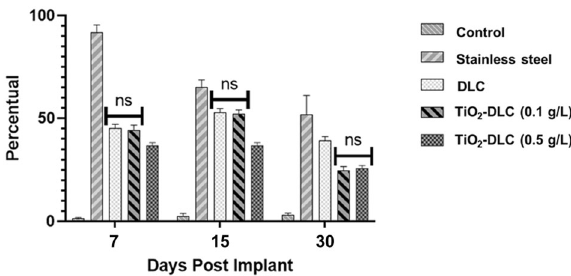
Fig. 2 Percentual of F4/80 — positive cells obtained by peritoneal lavage of different groups post-implant. Not was signi fi cative dif- ference between the groups DLC and DLC/TiO 2 (0.1 g/L). Data sig- ni fi cance performed by ANOVA